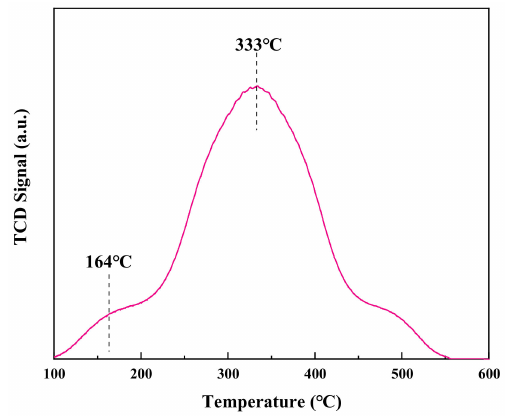
Figure 8. CO-TPD profile of CuCeO x -xK/Fe 2 O 3